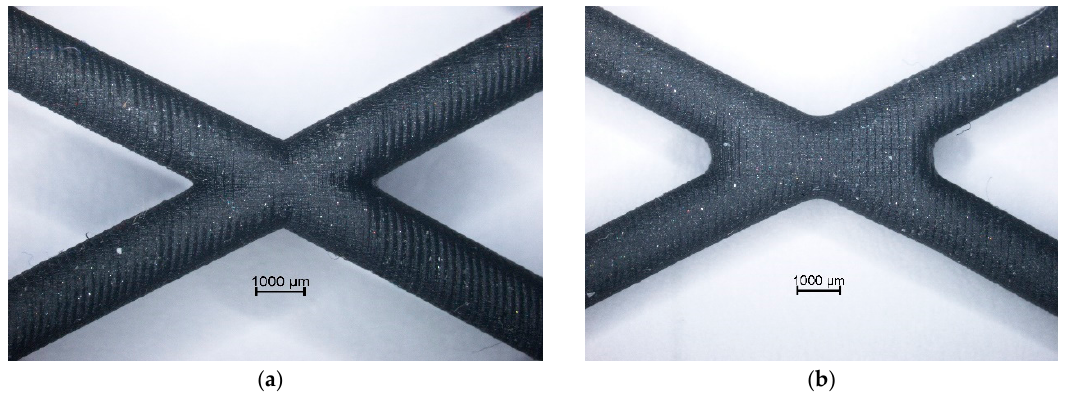
Figure 16. Node of the initial ( a ) and the improved geometry ( b ).